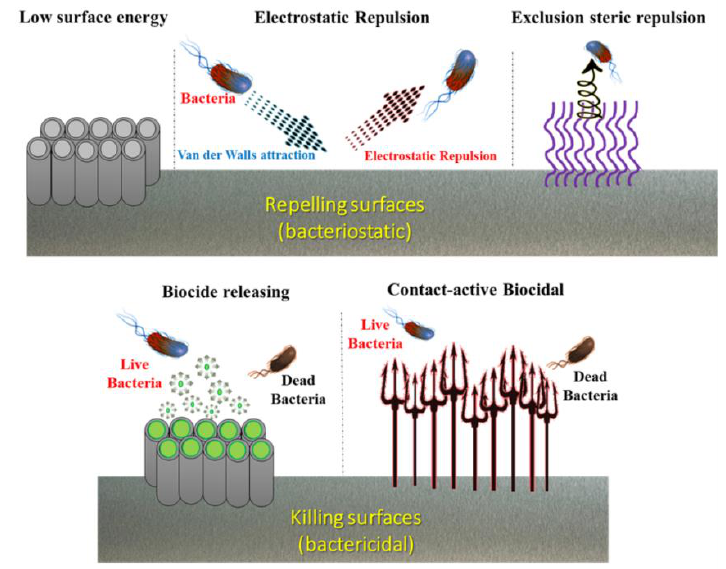
Figure 5. Schematic illustration of two surface modification strategies (bacteriostatic and bactericidal) in designing bactericidal surfaces.